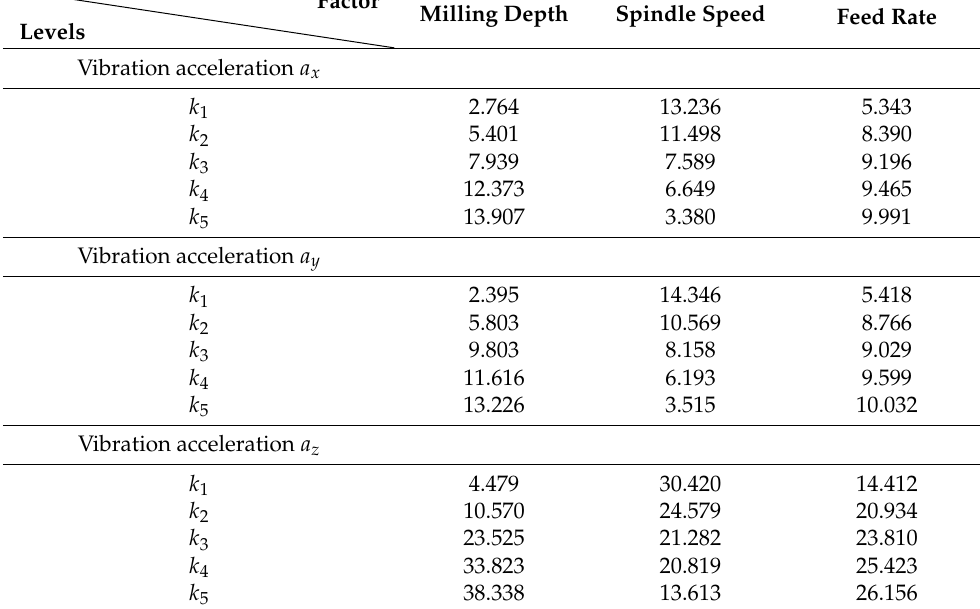
Table 10. Visual analysis results of vibration acceleration orthogonal